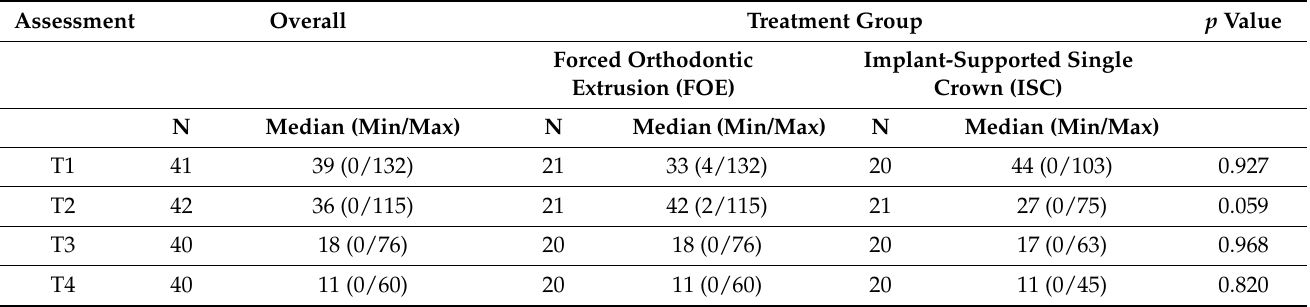
Table 2. Oral health-related quality of life (OHRQoL) for different time intervals stratified for treatment groups of forced orthodontic extrusion (FOE) and implant-supported single crowns